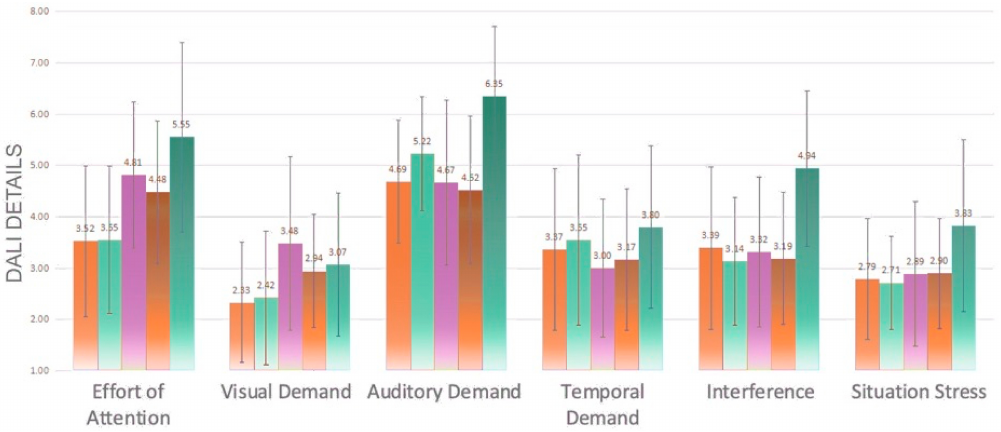
Figure 15. Detail values of the DALI scale of the five groups.